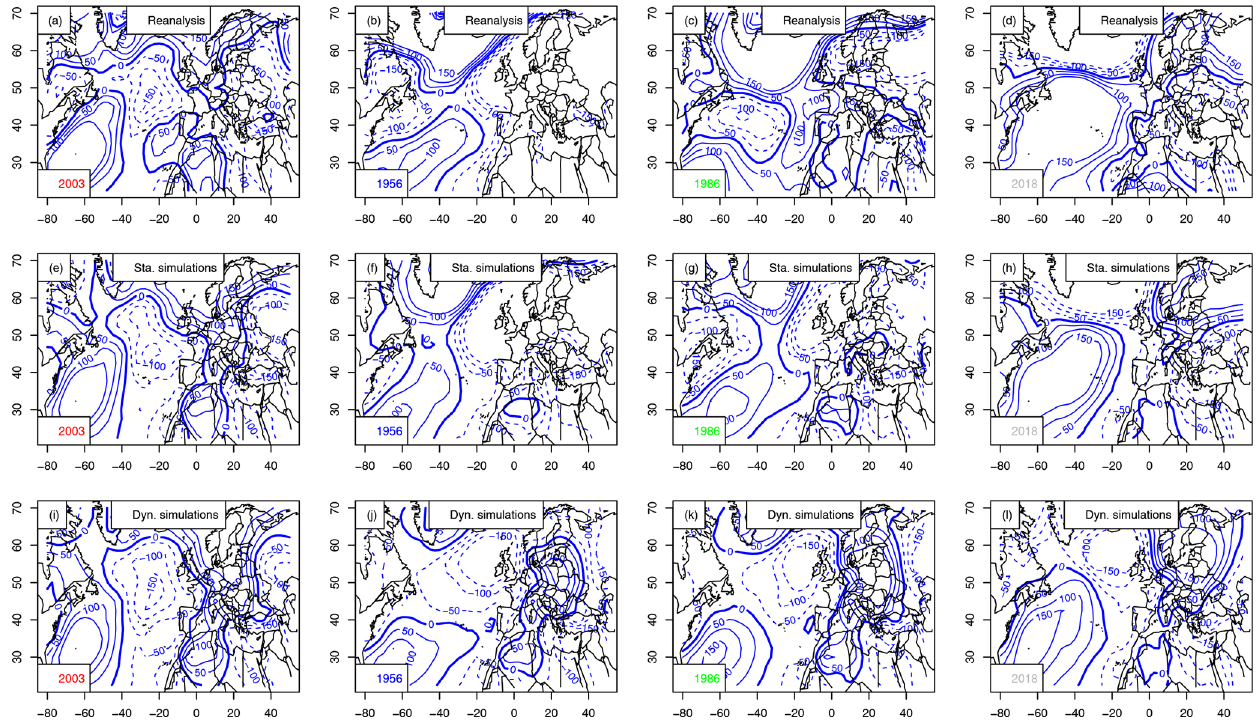
Figure 7. Maps of SLP anomaly composites (in Pa, with 50Pa increments) for the warmest summer (2003), coolest (1956), median (1986) and 2018. The 0hPa isoline is indicated with a thick blue line. Negative anomalies are in dashed isolines. Horizontal axes are for longitudes in degrees east. Vertical axes are for latitudes in degrees north. Upper row (a–d) : mean SLP from NCEP reanalyses. Center row (e–h) : static simulations. Bottom row (i–l) : dynamic